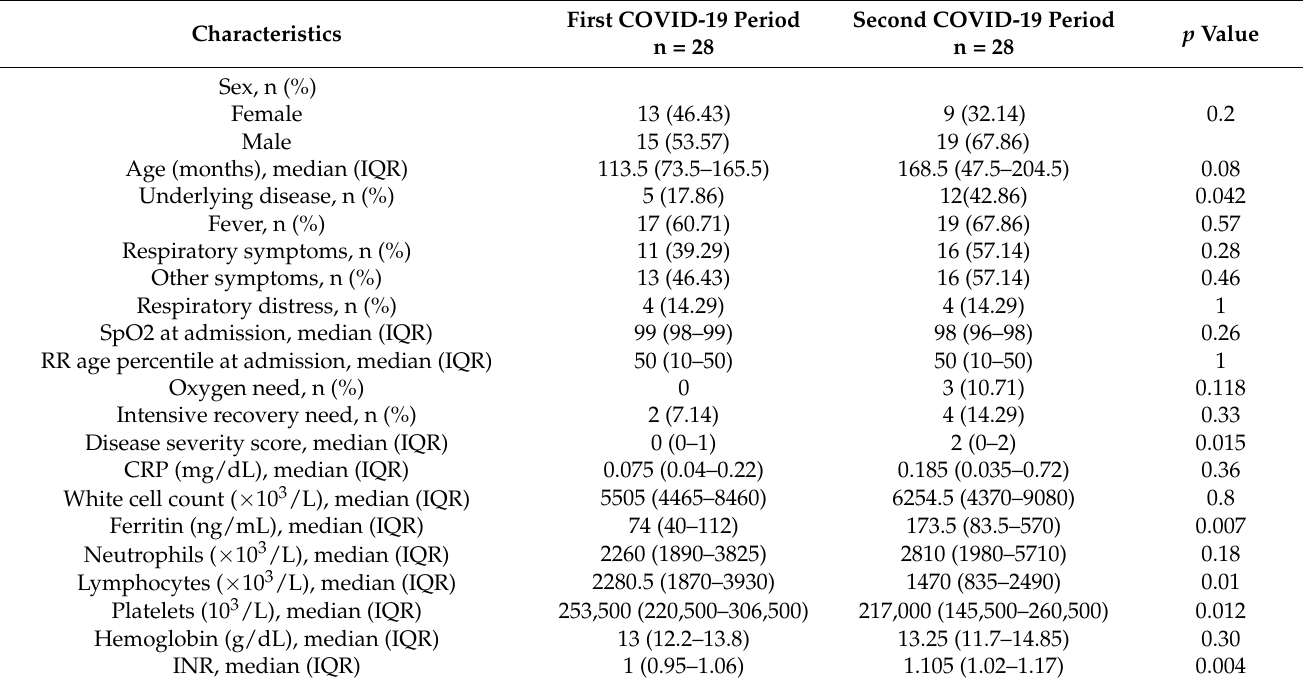
Table 2. Clinical, laboratory and LUS findings in the epidemic periods of the outbreak in children hospitalized for COVID-19